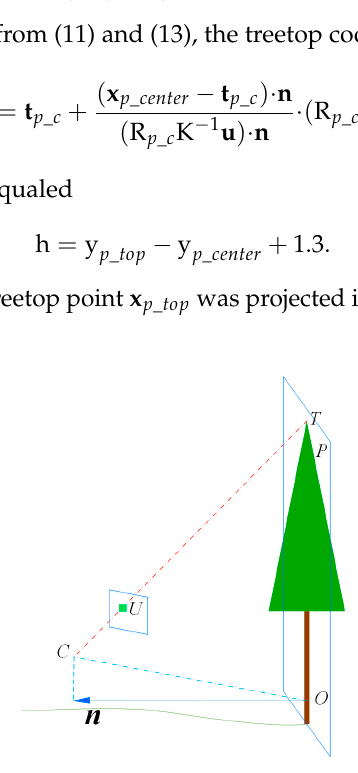
Figure 14. The geometric relationship between the points in the tree height solution. O is the center of the stem at breast height; C is the optical center of the camera; T is the treetop; U is the treetop pixel on the image; n is the horizontal component vector of the O C vector; and P is the plane whose normal vector is n and on which O is a point.